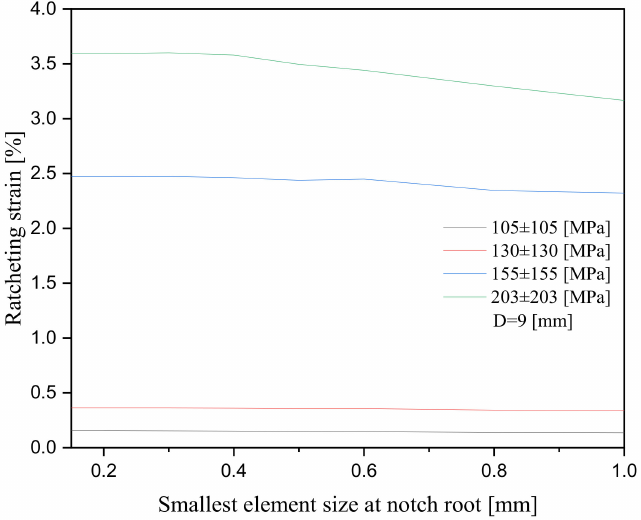
Figure 5. Convergence of ratcheting strain at notch root of the 1045 steel specimen (D = 9 mm) versus the quadratic mesh size at different stress levels for a given hysteresis